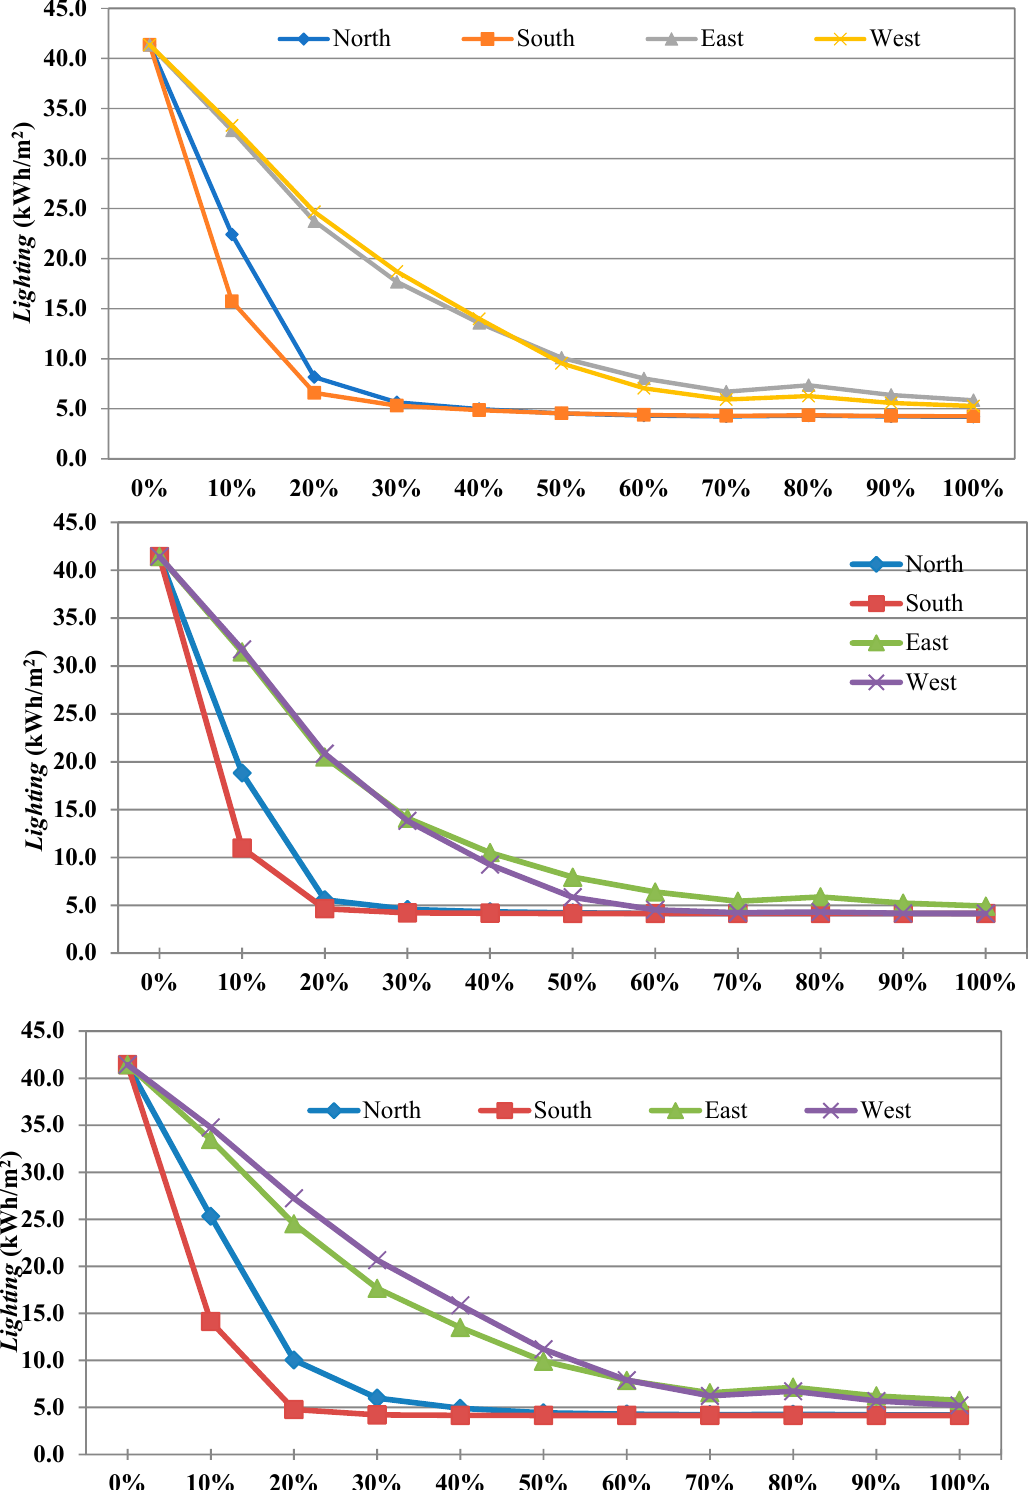
Figure 7. Annual lighting consumption of buildings with different percentages of windows in different facades for Bushehr (upper), Shiraz (middle), and Tabriz (below), Iran.